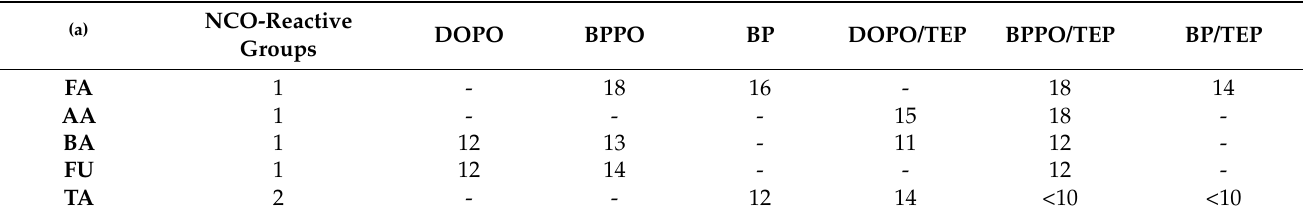
Table 5. Vertical flame spread data of the studied PIR foams with NCO-reactive phosphorus- containing FRs and water uptake > 20% (PIR foams without TEP: 0.7 wt.% P; PIR foams